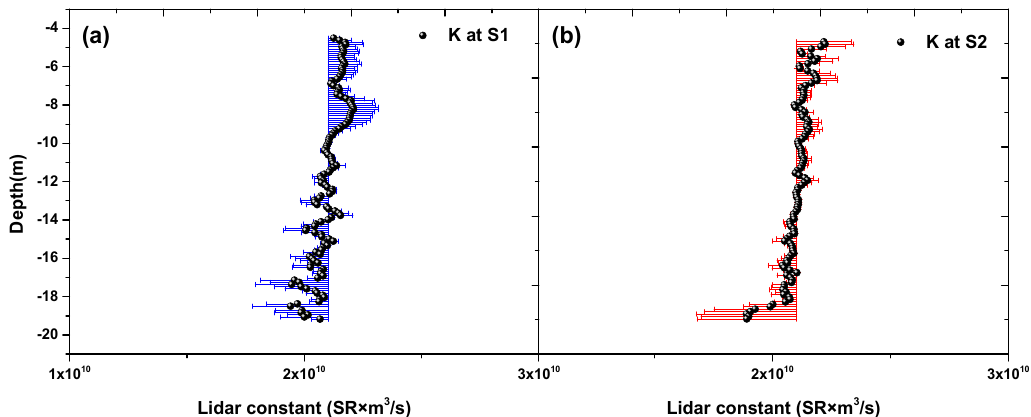
Figure 5. LiDAR constant calculated by bio optical models as a function of depth ( a – b ). The colored error bars denote standard deviation.